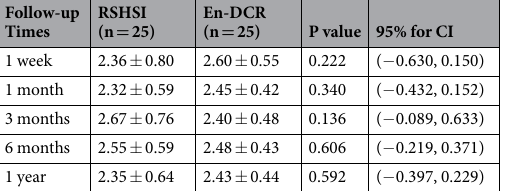
Table 4. Comparison of postoperative epiphora VAS scores. Two-tailed independent t test. Abbreviations: VAS, Visual Analogue Scale; CI, Confidence Interval; n, the number of operative eye. (Note: The 1 year follow-up in our study was composed of 6 months tube placement and 6 months follow-up after extubation).